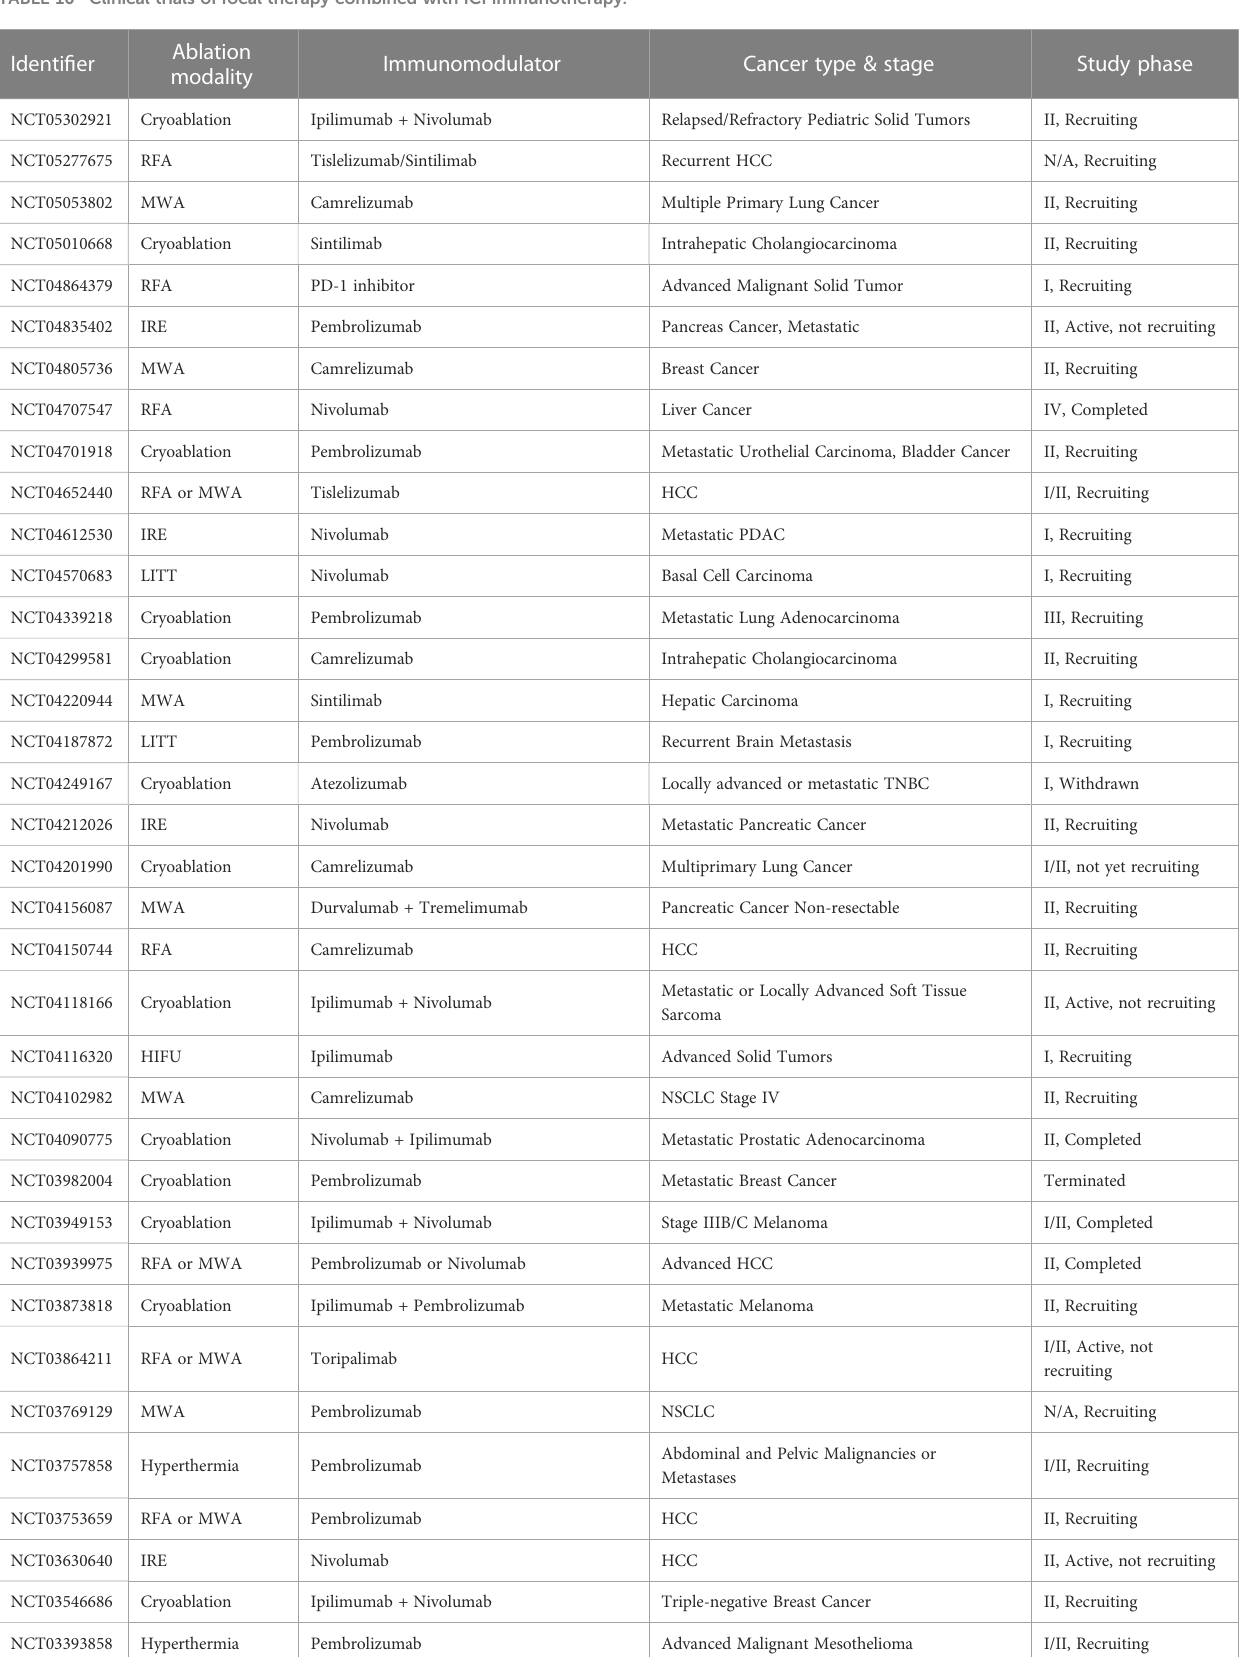
TABLE 10 Clinical trials of focal therapy combined with ICI